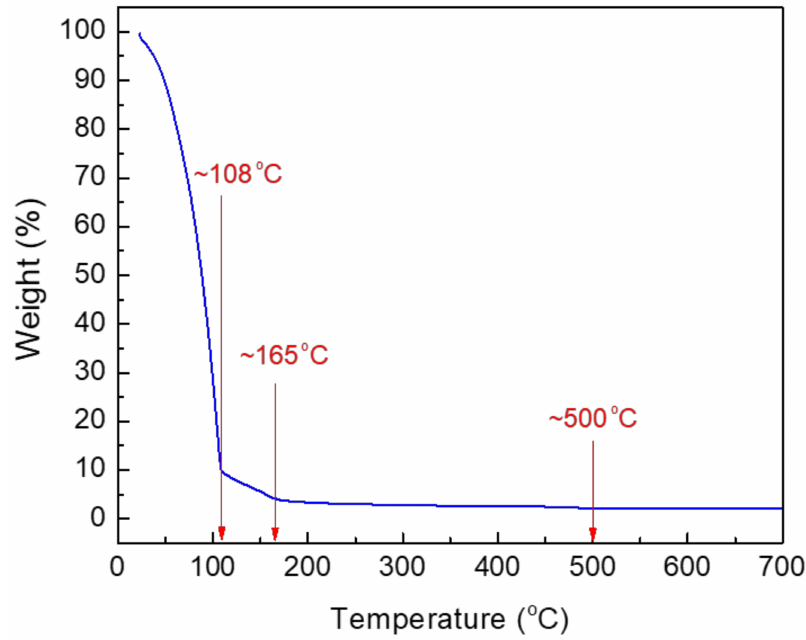
Figure 2. TGA characteristic curve of the prepared CuO precursor solution.